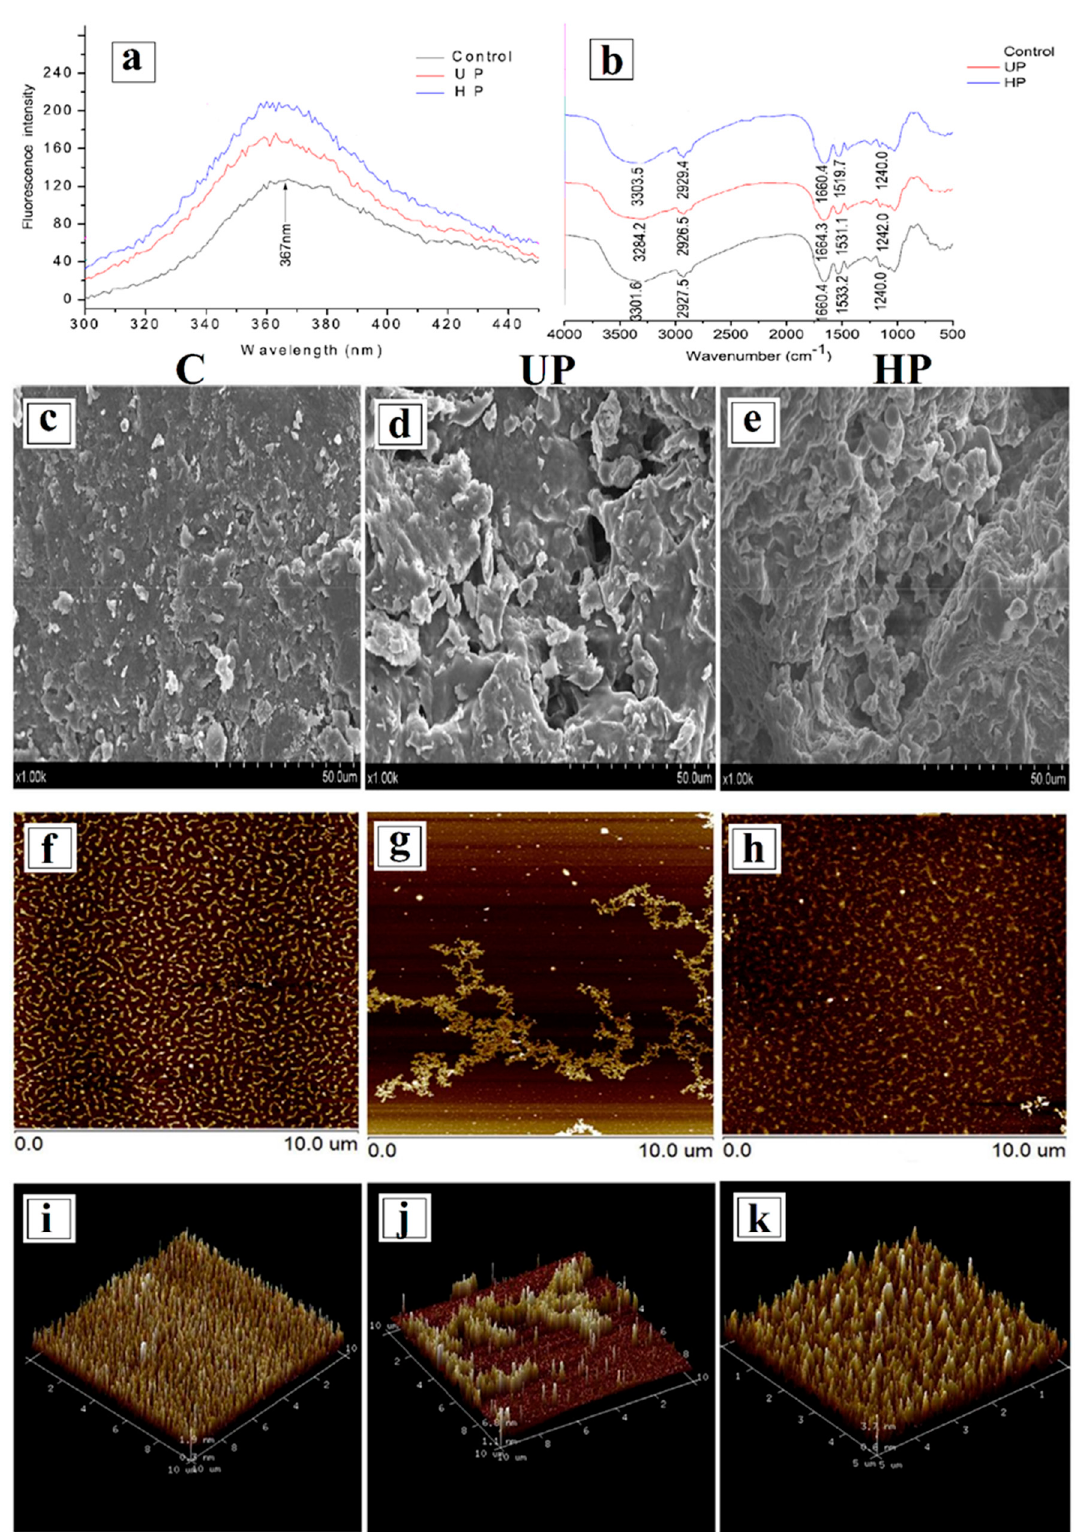
Figure 2. Effect of heat and ultrasound pretreatments on the fluorescence spectra ( a ), Fourier Transform Infrared (FTIR) spectra ( b ), scanning electron microscopy (SEM) ( c – e ), atomic force microscopy (AFM) microstructure ( f – h ), and three-dimensional (3D) images ( i – k ) of corn gluten meal. C, Control; UP, Ultrasound pretreatment and HP, Heat treatment, respectively. Reproduced with permission from [33].